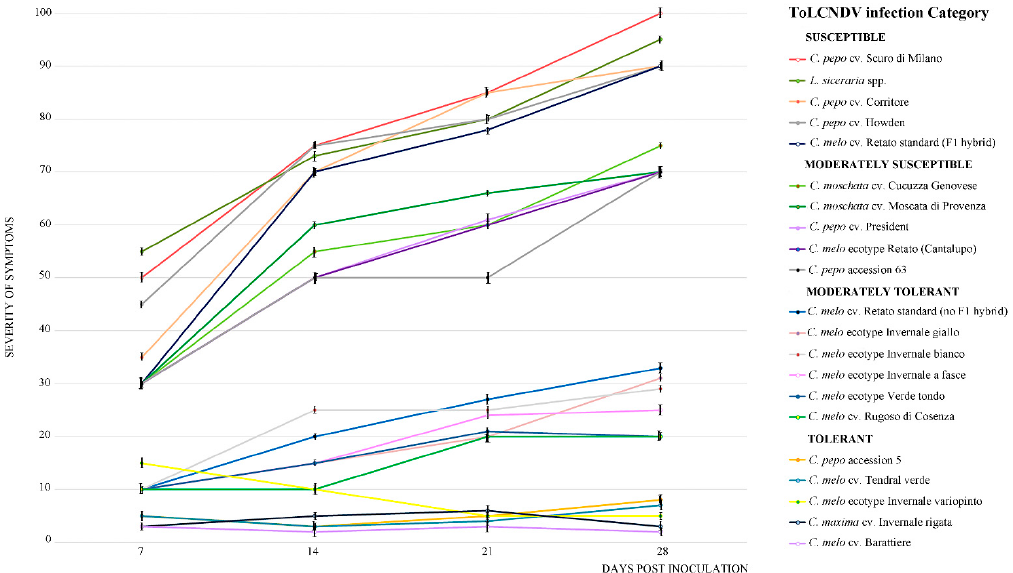
Figure 2. Severity of ToLCNDV-Le symptoms (from 0, absent, to 100, maximum severity, distributed in four equal parts) observed at 7, 14, 21, and 28 dpi in the 21-cucurbit genotypes infected by ToLCNDV-Le estimated according to the criteria reported in Table 1. Each point on the line chart represents average of ten plants of the same genotype showing the same symptom severity and error bars on lines represent the standard error among plants. Mock-inoculated plants served as negative control.